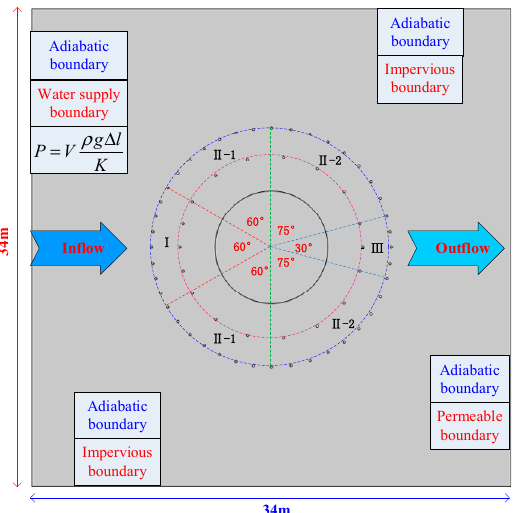
Figure 14. Numerical calculation model of double-circle freezing holes.